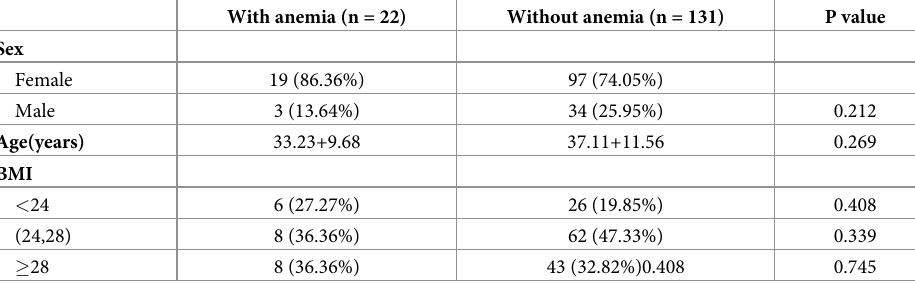
Table 1. Demographic information of IIH patients in the two groups. With anemia (n =